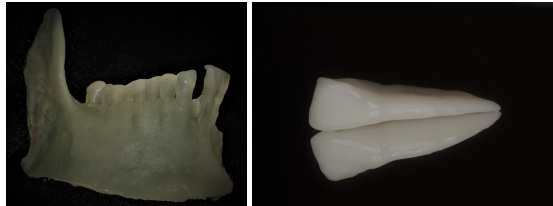
Figure 11. Final view of mandible fragment (a left) and reconstruction of the whole mandible (b right)) Figure 11 a, b. Printed mandible right part (a left) and lower lateral incisor (b